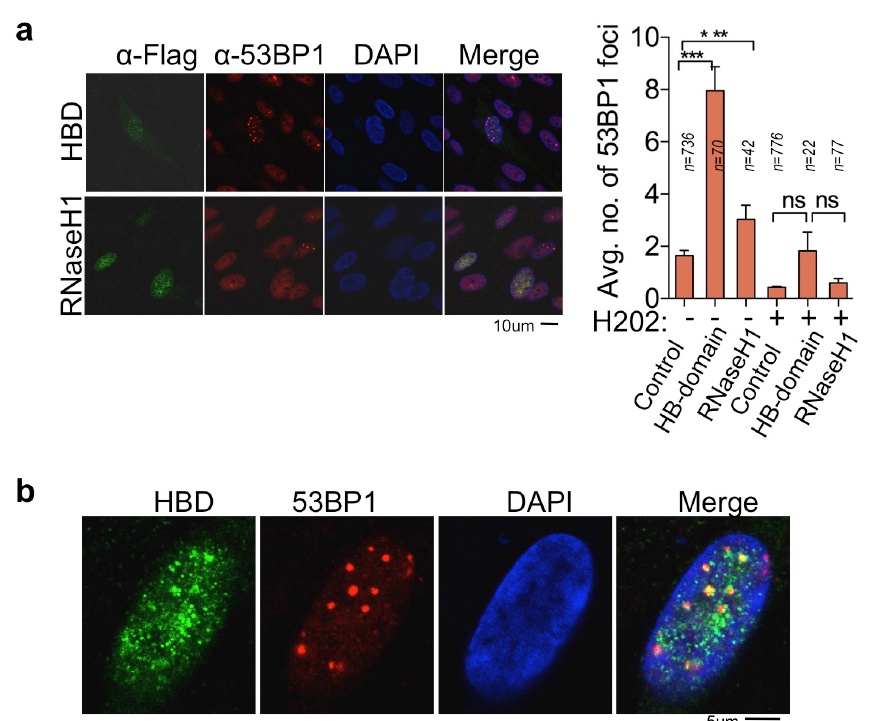
Figure 6. RNA:DNA hybrids promote 53BP1 foci formation. ( a ) Immunofluorescence using the anti-flag and anti-53BP1 antibody in cells expressing Flag-tagged hybrid-binding (HB) domain or flag-tagged active RNaseH1. 53BP1 foci were quantified in cells expressing HB-domain or RNaseH1. Column bars represent the mean of n number of cells (described on each column), from three independent experiments. Error bars represent SEM. *P ≤ 0.05; **P < 0.01, ***P < 0.001 using the Kruskal-Wallis test followed by Dunn’s post hoc test. ( b ) Higher zoom representative images show HB-domain and 53BP1 co-localization, specifically in the euchromatin area.